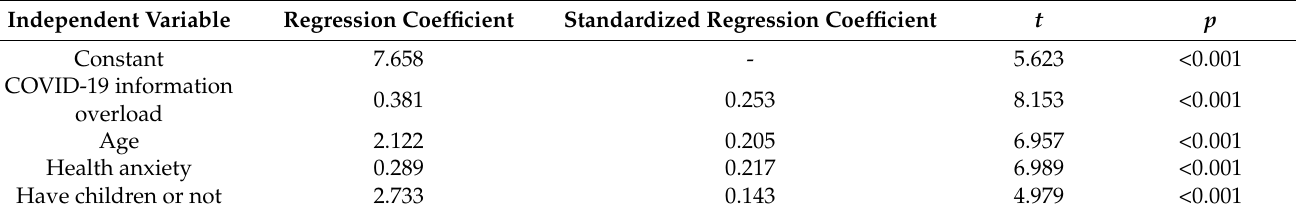
Table 4. Multiple-factor analysis of COVID-19 information avoidance among elderly people in Wuhan, China ( n = 907). Standardized Regression